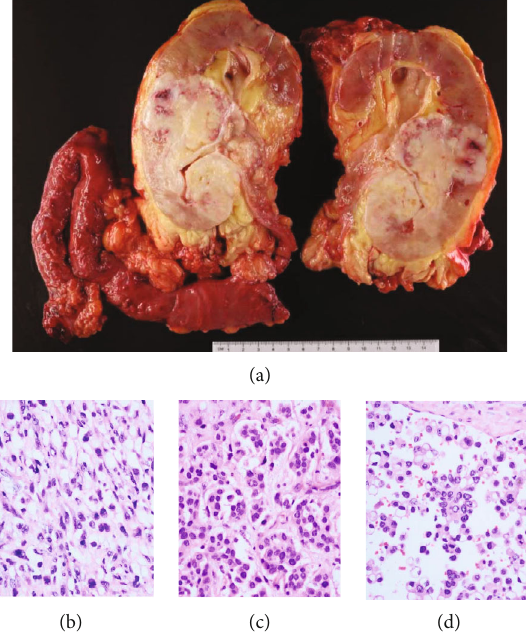
Figure 6: (a) For case 2, sectioning of the kidney revealed a 9.6cm irregular solid mass grossly invading into the hilar fat and into perinephric fat. (b – d) Hematoxylin and eosin stain showed invasive high grade urothelial carcinoma with divergent di ff erentiation, including prominent sarcomatoid di ff erentiation (b), glandular (c), plasmacytoid and signet ring cell di ff erentiation (d) ( × 400 magni fi